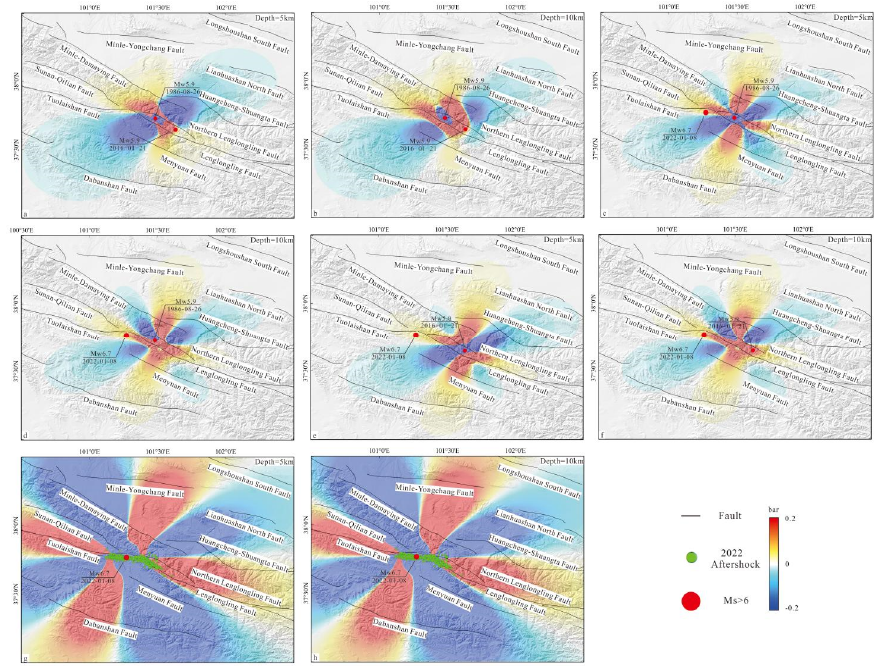
Figure 6. Coulomb stress change. ( a , b ) The 1986 Menyuan earthquake seismogenic fault was set as the source fault, the 2016 Menyuan earthquake seismogenic fault was set as the receiver fault, and the Coulomb stress was calculated at depths of 5 km and 10 km, respectively. ( c , d ) The 1986 Menyuan earthquake’s seismogenic fault was set as the source fault, the 2022 Menyuan earthquake seismogenic fault was set as the receiver fault, and the Coulomb stress was calculated at depths of 5 km and 10 km, respectively. ( e , f ) The 2016 Menyuan earthquake seismogenic fault was set as the source fault, the 2022 Menyuan earthquake seismogenic fault was set as the receiver fault, and the Coulomb stress was calculated at depths of 5 km and 10 km, respectively. ( g , h ) The 2016 Menyuan earthquake seismogenic fault was set as the source fault, the 2022 Menyuan earthquake seismogenic fault was set as the receiver fault, and the Coulomb stress was calculated at depths of 5 km and 10 km, respectively.